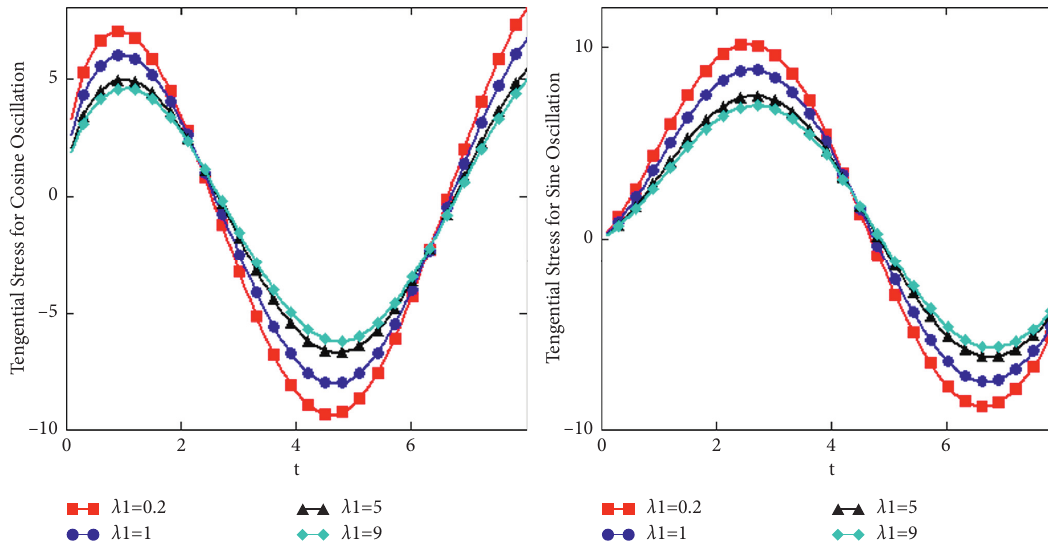
Figure 10: The variation of λ